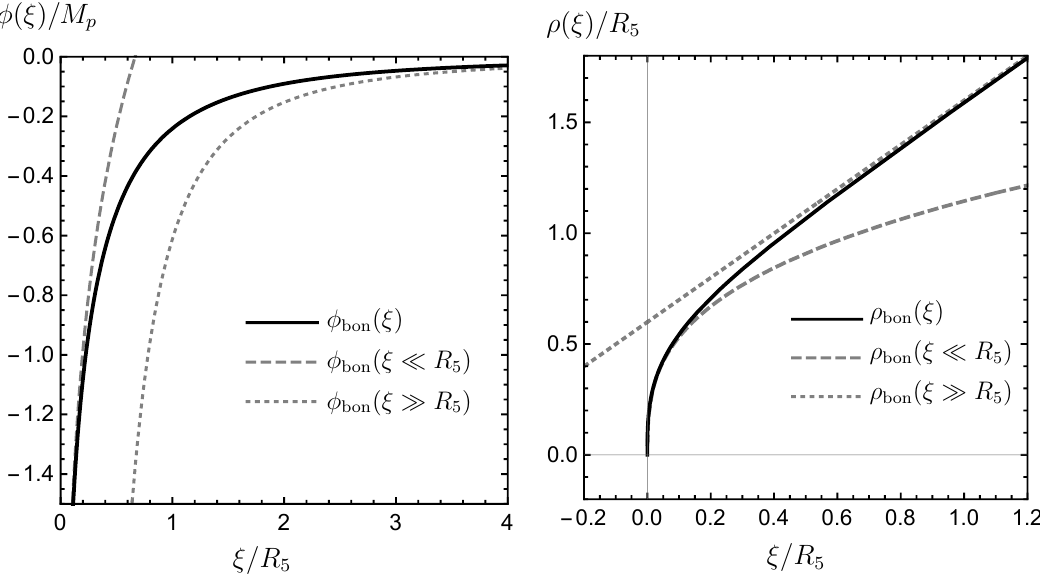
Figure 3 . The five-dimensional Euclidean Schwarzschild gravitational instanton, or Witten’s BON, expressed in terms of the degrees of freedom φ CDL problem. The behavior of the solutions in the near-horizon ( ξ (cid:28) R regimes is indicated in the figure, following eq. (2.21) and eq. (2.22),